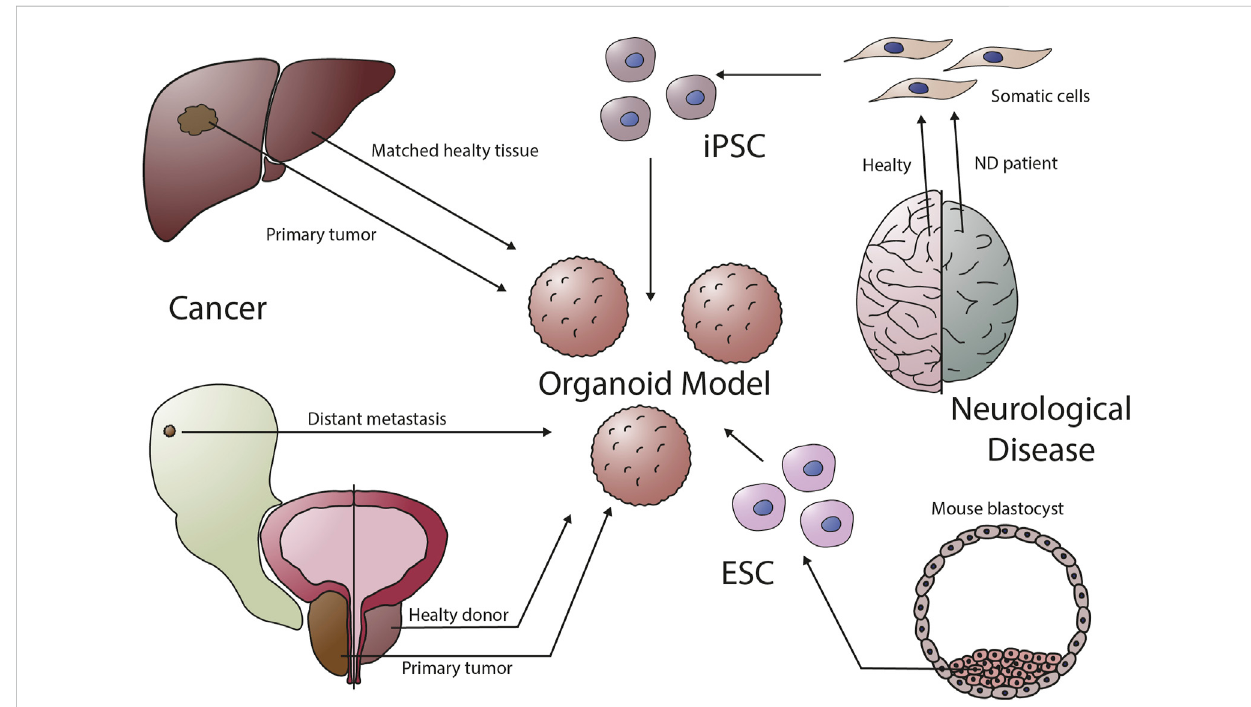
FIGURE 1 Schematic overview of organoid origin. Organoids can be established from various healthy and cancer-derived organs. ESCs isolated from mouse